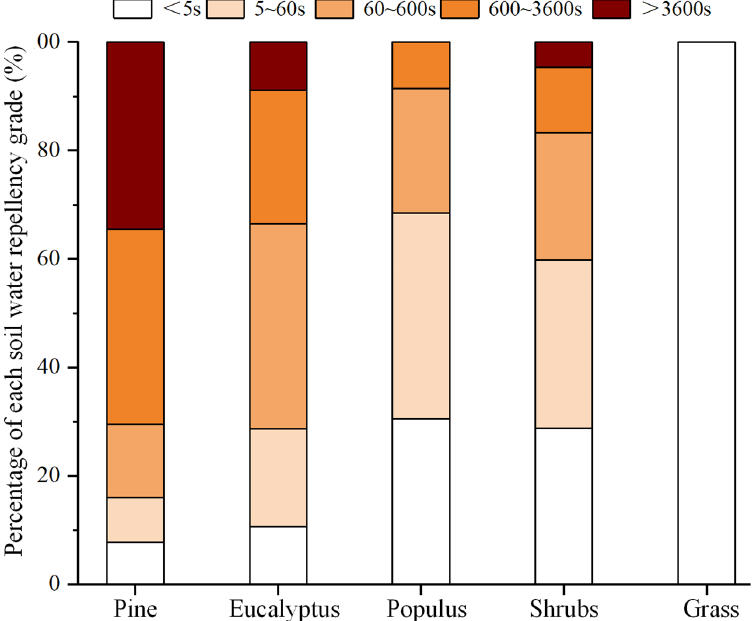
Figure 8. Field investigation of soil water repellence under different vegetation types in burned areas in the study area. WDPT was all measured one hundred times in the soil under different vegetation with the same burned severity. The five water repellency levels in this figure are: wettable (WDPT ≤ 5 s), slightly water repellency (5 s < WDPT ≤ 60 s), strongly water repellency (60 s < WDPT ≤ 600 s), severely water repellency (600 s < WDPT ≤ 3600 s), extremely water repellency (WDPT > 3600 s).